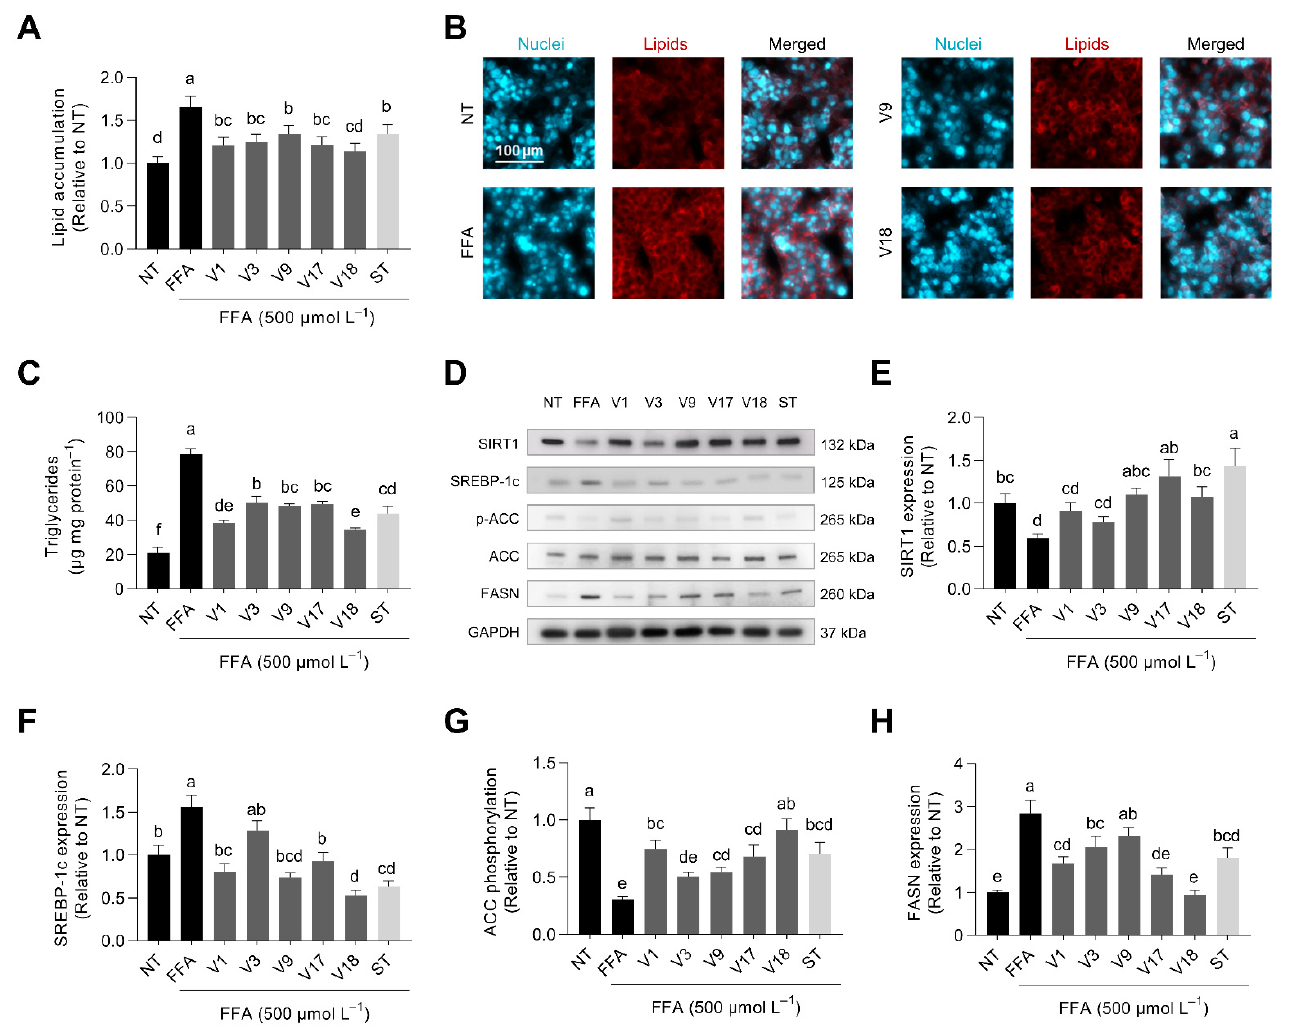
Figure 7. Effect of selected soybean digests (V1, V3, V9, V17, and V18 at 253, 160, 76, 64, and 146 µ g protein mL − 1 , respectively) and simvastatin (ST, 160 ng mL − 1 ) on the intracellular lipid accumulation ( A , B ), triglyceride concentration ( C ), the relative protein expression/phosphorylation ( D ) of sirtuin 1 (SIRT1) ( E ), sterol regulatory element-binding protein 1c (SREBP-1c) ( F ), acetyl-CoA carboxylase (ACC) ( G ), and fatty acid synthase (FASN) ( H ) in free fatty-acid-stimulated HepG2 liver cells (500 µ mol L − 1 oleic: palmitic acid, 2:1). Results are reported as mean ± SD ( n = 3). Bars with different letters significantly differ according to ANOVA and Tukey’s multiple range test ( p < 0.05).